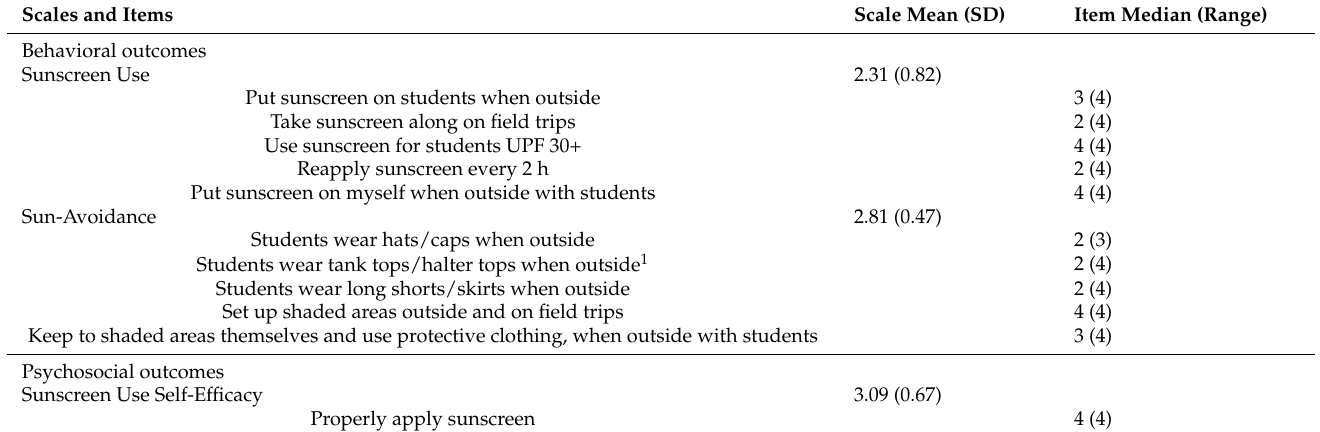
Table 6. Baseline item ratings of preschool staff members ( n =